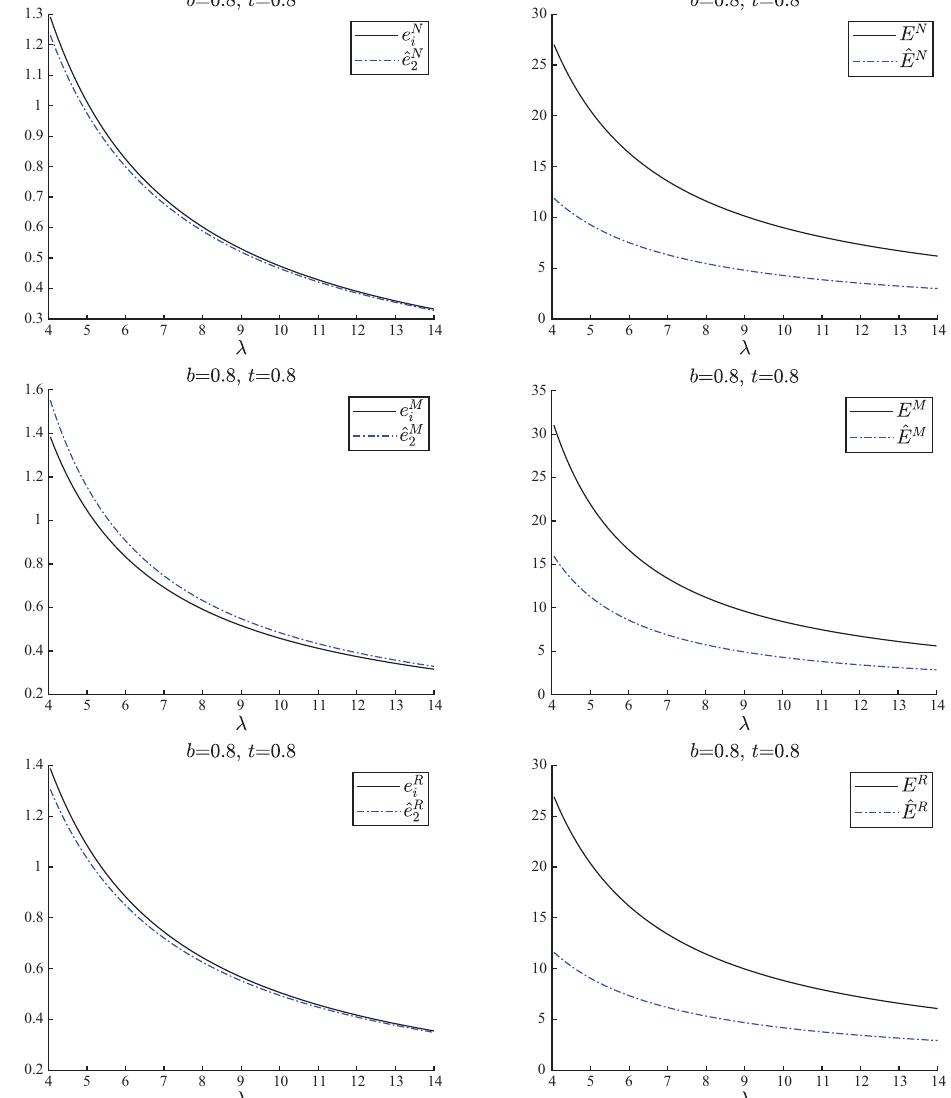
Figure 6. Unit/total carbon emission reduction in the symmetric/asymmetric investment